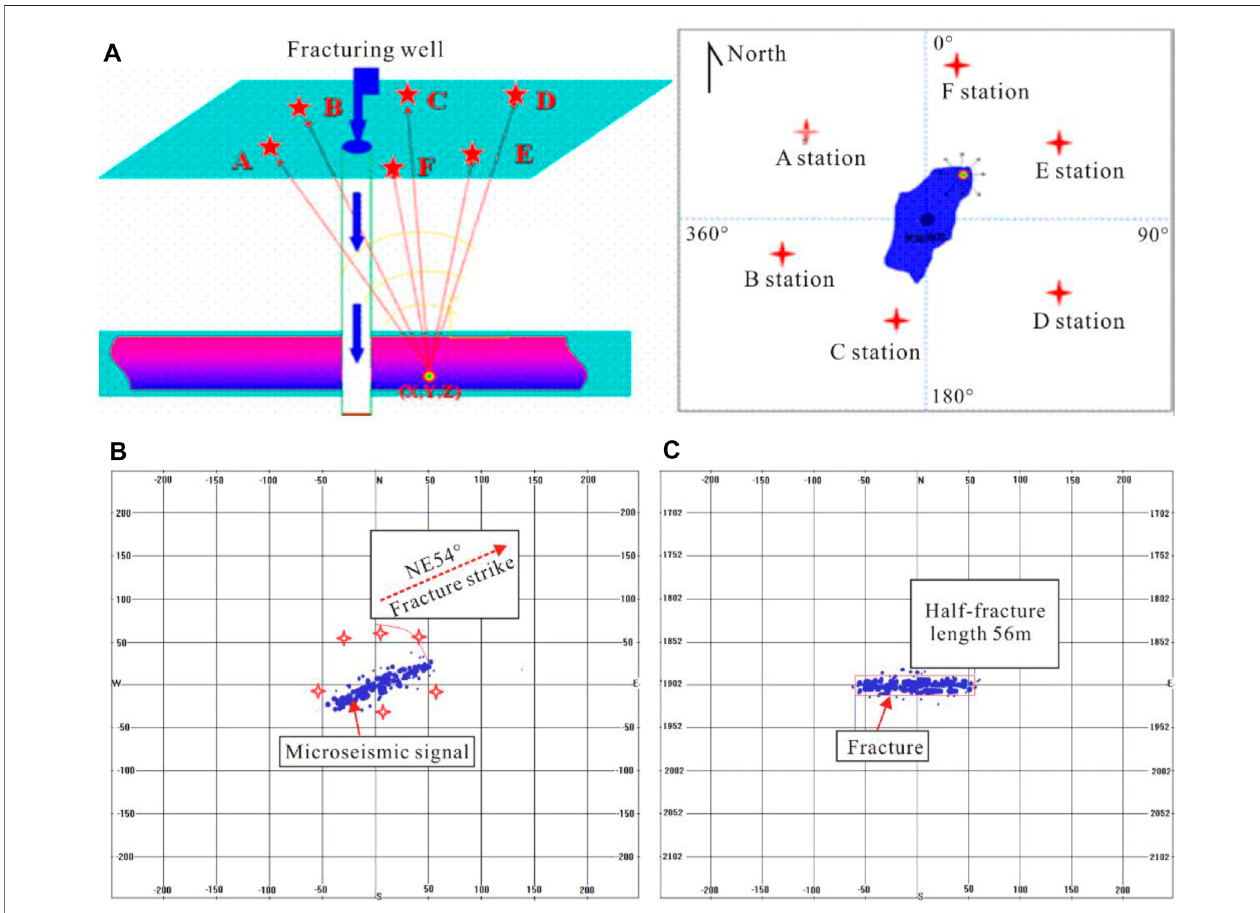
FIGURE 4 | Microseismic fracture monitoring of Well N1. (A) Distribution of 6 seismic monitoring stations; (B) Main strike of hydraulic fractures; (C) Half-length of hydraulic fractures.